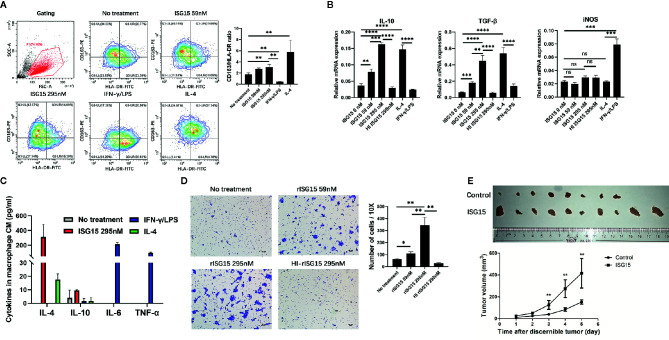
Interferon-stimulated gene 15 (ISG15) induced the M2-like phenotype and promoted NPC cell migration and tumorigenicity. (A, B) Human peripheral blood mononuclear cell (PBMC)-derived macrophages treated with 59 nM and 295 nM rISG15 for 24 h, and then were detached for fluorescence activated cell sorting (FACS) analysis, or were extracted mRNA for qPCR analysis. (A) Representative data of the switched surface markers profile of M2 (CD163)/M1 (HLA-DR) in ISG15-treated macrophages measured by FACS. (B) rISG15 induced macrophage mRNA expression of M2 cytokines, such as IL-10 and TGF-β, but not of M1 cytokines, such as iNOS, by qPCR analysis. IFN-γ/LPS and IL-4 served as positive control for M1 and M2 polarization. Heat-inactivated recombinant ISG15 (HI ISG15) protein was boiled within 100°C for 15 min. (C) Cytokine panel indicated the increased secretion of M2-polarizing cytokine IL-4 in culture supernatants of ISG15-treated macrophages, but not of M1-polarizing cytokine IL-6 and TNF-α. The culture supernatants were harvested from the macrophages upon rISG15 treatment at indicated dose for 24 h and replaced with serum-free culture for 24 h. (D) Representative photography of transwell filters in HK1 NPC cells cultured with the culture medium (CM) of macrophages. Quantification analysis revealed the increased number of transwell cell in the presence of ISG15 treatment. Data are expressed as mean ± SD of three independent experiments. *p < 0.05, **p < 0.01, ***p < 0.001, and ****p< 0.0001. (E) Photographic illustration of the grow tumors established by a tumor model within BALB-c mice through subcutaneous inoculation with a mixture of human HK1 NPC cells and PBMC-derived macrophages (at ratio of 3:1) with or without rISG15 pre-treatment. All (10 in 10) mice with ISG15 treatment had tumor grow, but only 8 of 10 mice in the control group had tumor grow. The growth curve showed a significant larger tumor volume in the ISG15 treatment group compared with that of the control. ns, not significant.